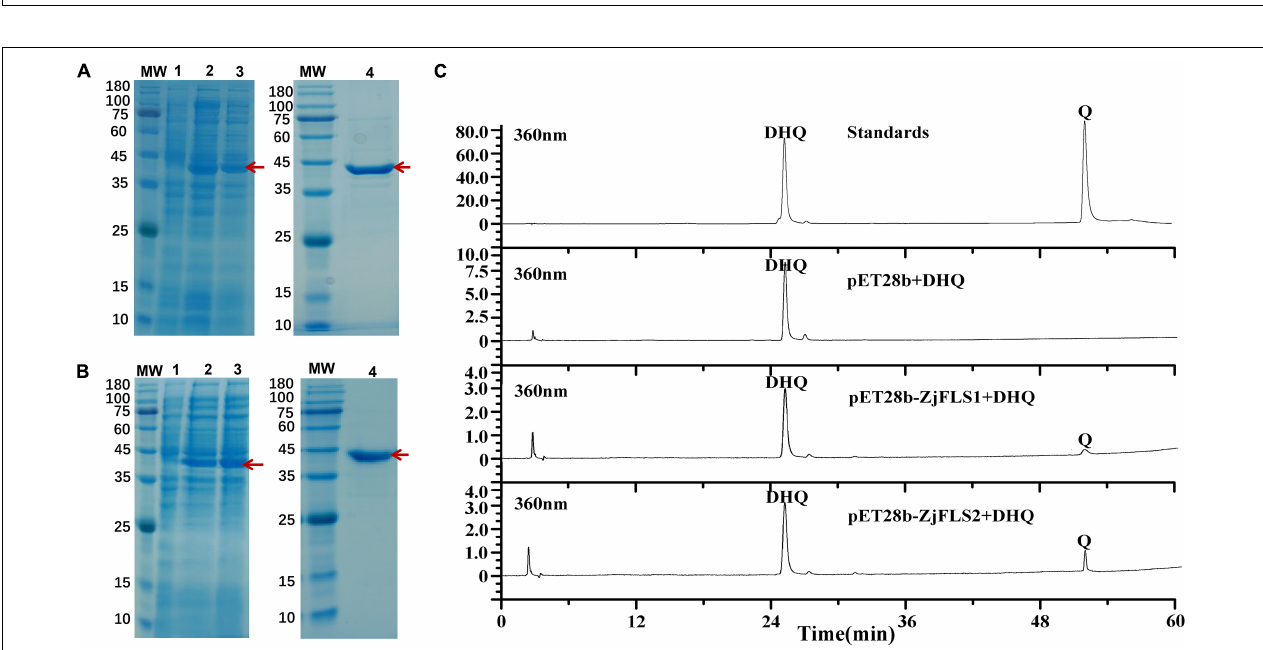
FIGURE 7 | Prokaryotic expression and detection of enzymatic reaction products of ZjFLS1 and ZjFLS2 in vitro . (A) Analysis of ZjFLS1 recombinant protein by SDS–PAGE. (B) Analysis of ZjFLS2 recombinant protein by SDS–PAGE. MW, Molecular weight marker. Lane 1, non-induced recombinant bacteria (Control). Lanes 2–3, induced proteins of recombinant bacteria. Lane 4, the final protein sample. (C) Detection of enzymatic reaction products in vitro .